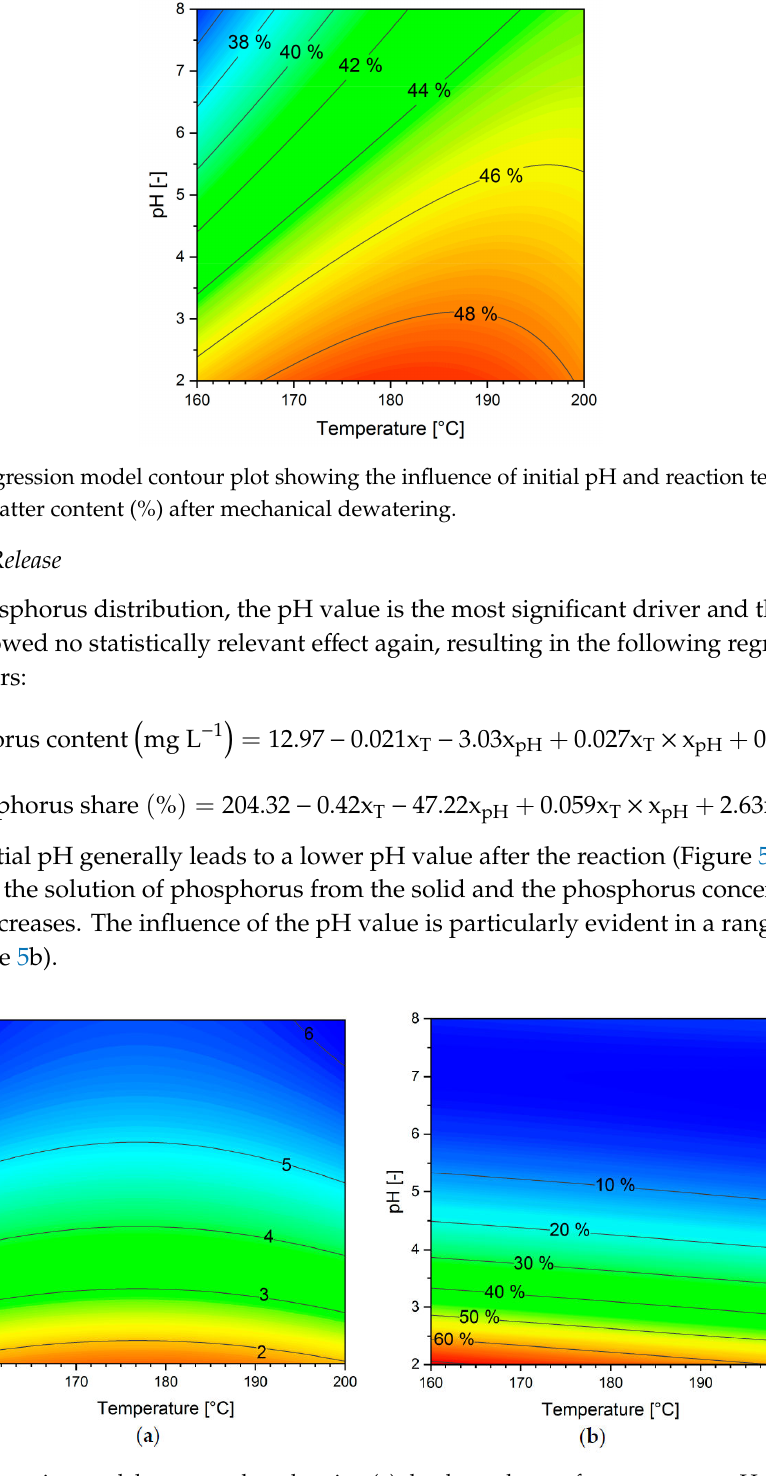
Figure 5. Regression model contour plots showing ( a ) the dependence of process water pH and ( b ) the dependence of liquid phase phosphorus release (% of total P) on reaction temperature and initial